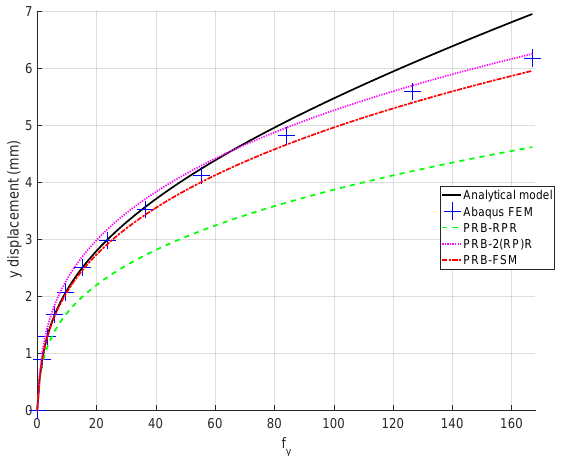
Figure 12. Comparison of the software results with analytical model (Hao and Li, 2015) and ABAQUS software. f y is normal- ized as shown in Eq.